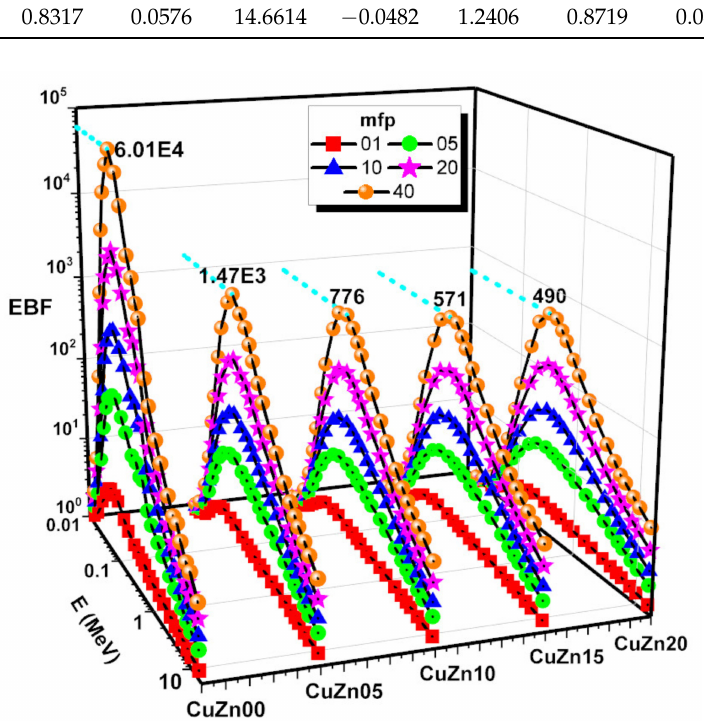
Figure 11. Exposure buildup factor (EBF) against photon energy of samples at 1, 5, 10, 20 and 40